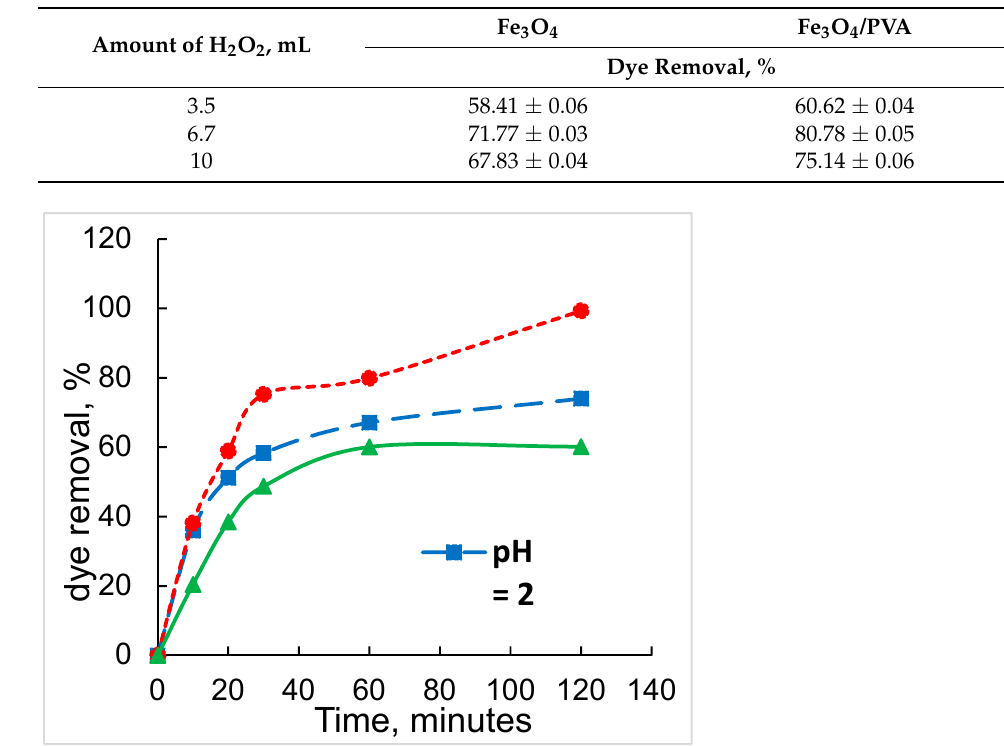
Table 2. Dye removal percentage values for composite at different amounts of hydrogen peroxide (H 2 O 2 ).